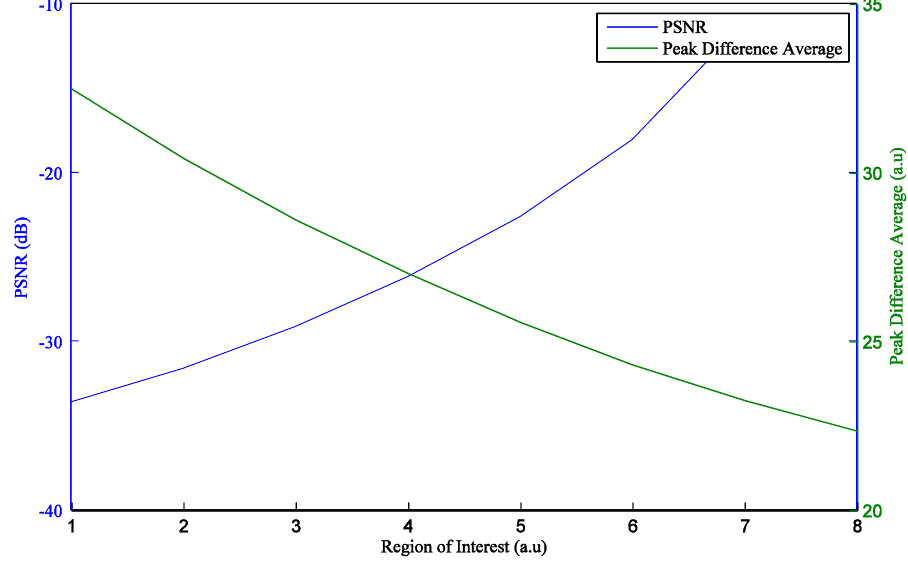
Figure 17. PSNR and i * with ROIs.